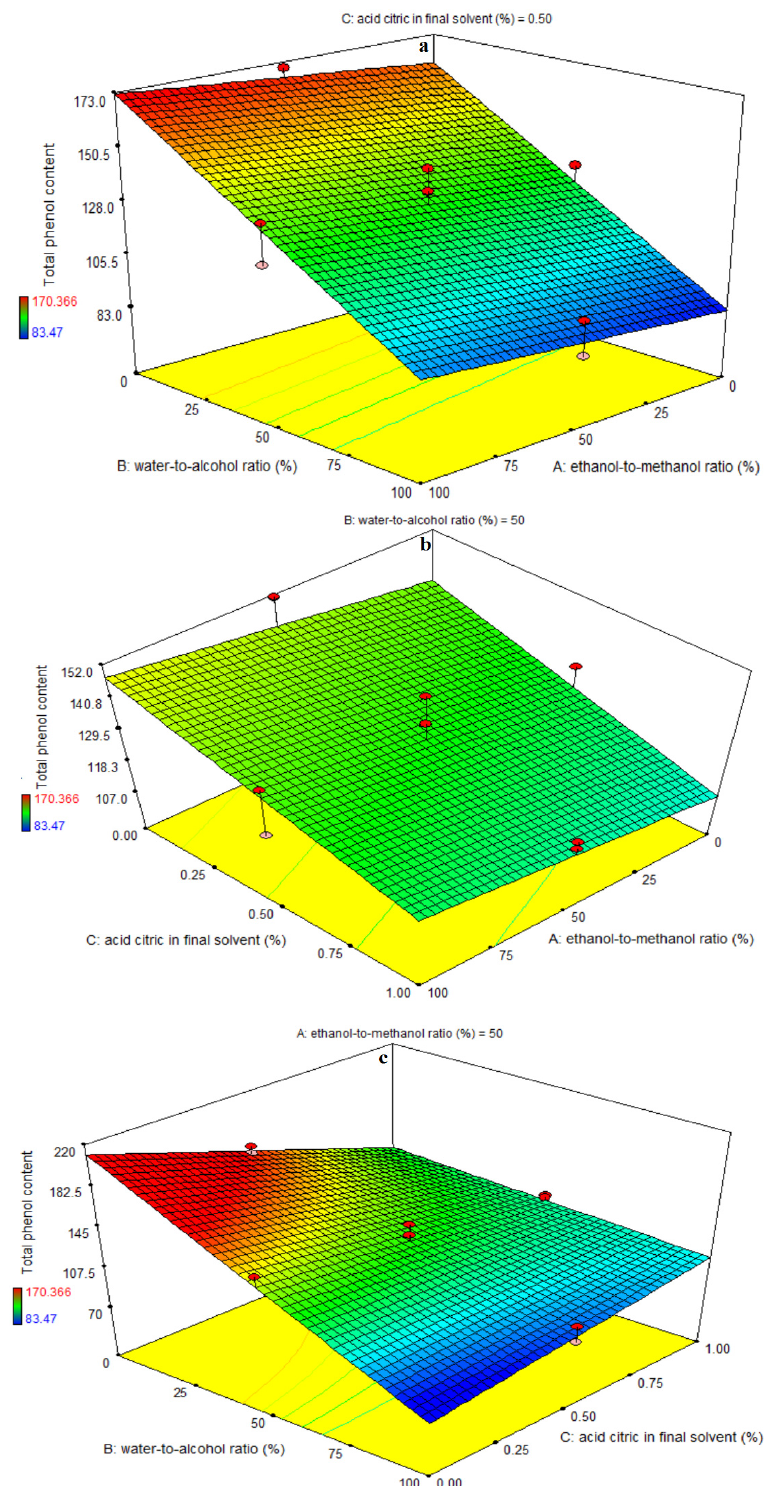
Figure 1. Effects of ethanol-to-methanol ratio (%), water-to-alcohol ratio (%) and citric acid in final solvent (%) on total phenol content (mg Gallic acid/g dry extract) in eggplant peel extraction. ( a ): The interaction effect of factors A and B on the intermediate level of factor C., ( b ): The interaction effect of factors A and C on the intermediate level of factor B., and ( c ): The interaction effect of factors B and C on the intermediate level of factor A.